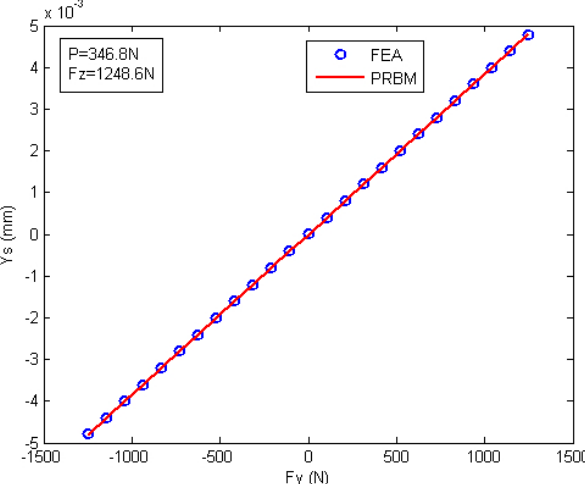
Figure 7. Primary translational displacement verification: primary sti ff ness.